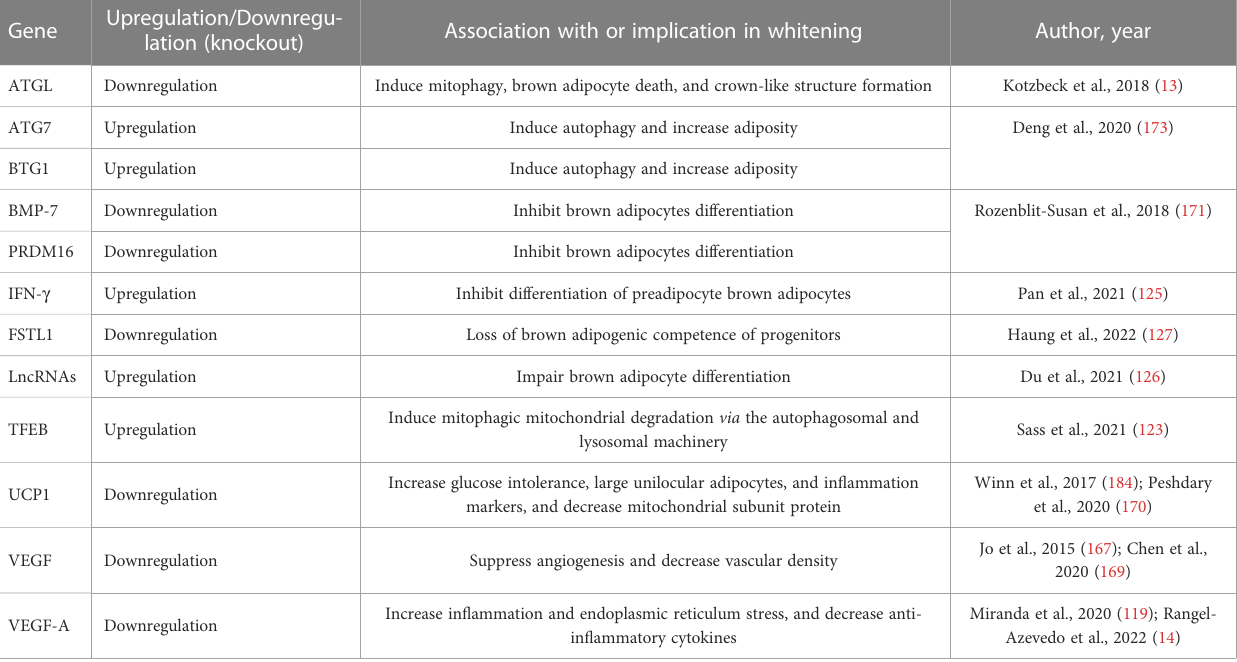
TABLE 3 An overview of the potential biomarkers of BAT/beige adipose tissue whitening. Upregulation/Downregu- Gene Association with or implication in whitening Author, year lation (knockout) ATGL Kotzbeck et al., 2018 (13)